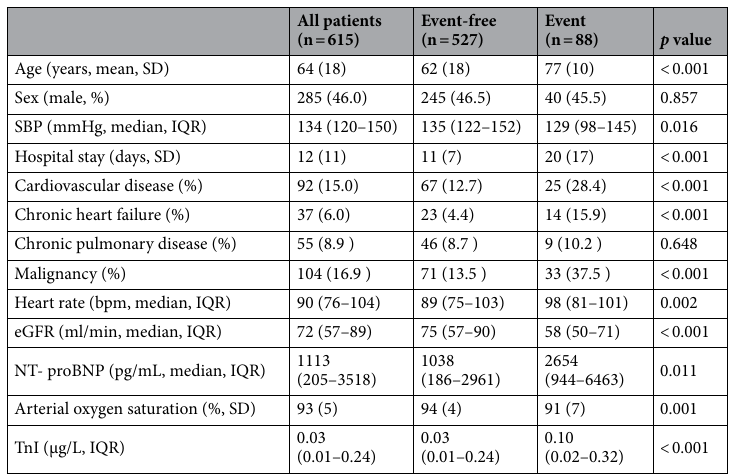
Table 1. Baseline patient characteristics. Abbreviations: eGFR—estimated glomerular filtration rate, IQR— interquartile range, NT-proBNP—N-terminal pro-brain natriuretic peptide, SBP—systolic blood pressure, SD—standard deviation, TnI—troponin I.